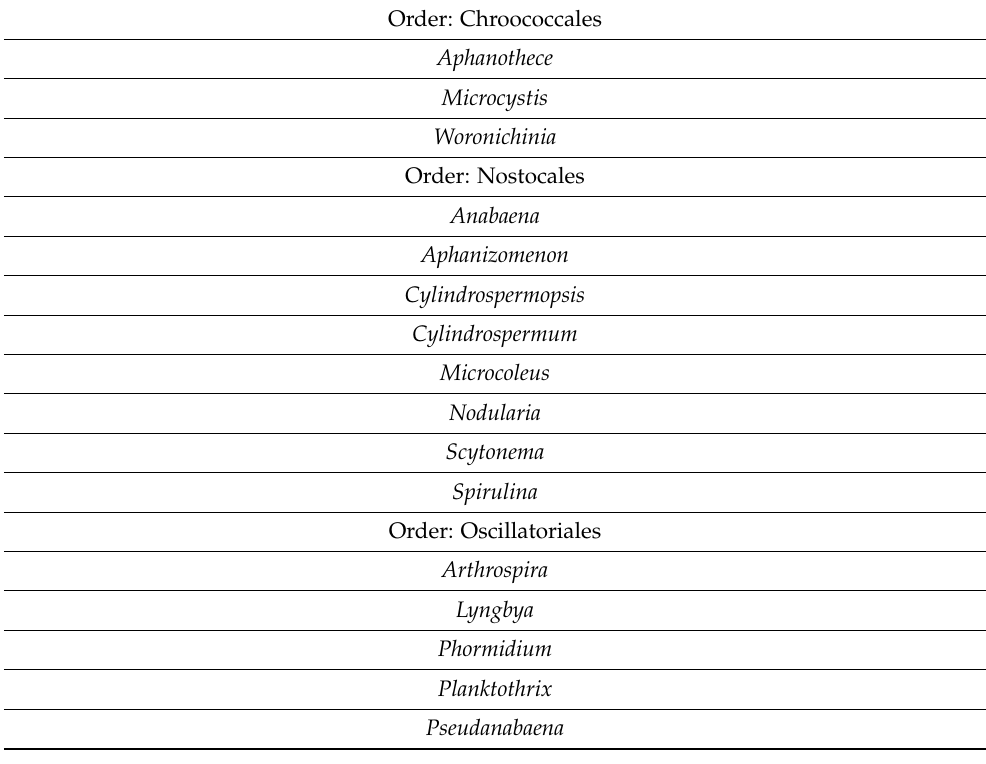
Table 1. List of cyanobacterial genera used to evaluate their effects on zooplankton.